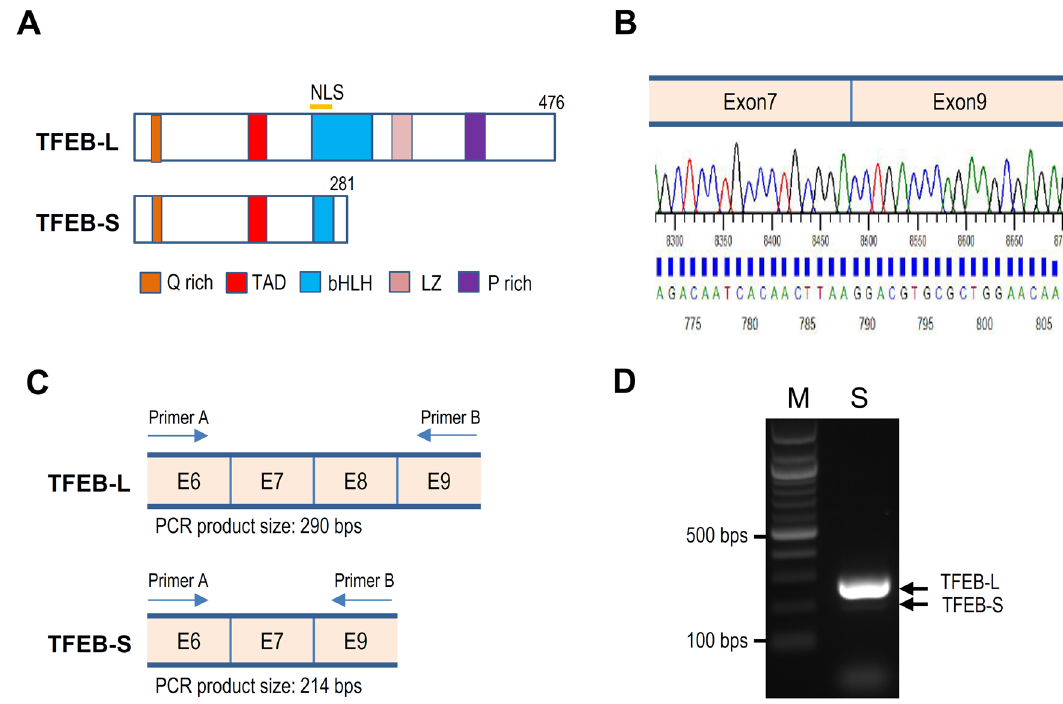
Figure 1. A small TFEB splicing variant lacking the helix-loop-helix and leucine zipper (HLH-LZ) region is present in human cell lines. ( A ) A schematic comparison of TFEB-L and small TFEB (TFEB-S). Q rich glutamine rich, TAD transactivation domain, NLS nuclear localization signal, bHLH basic helix-loop-helix, LZ leucine zipper, P rich proline rich. ( B ) The small TFEB cDNA cloned into the pHM6 plasmid was